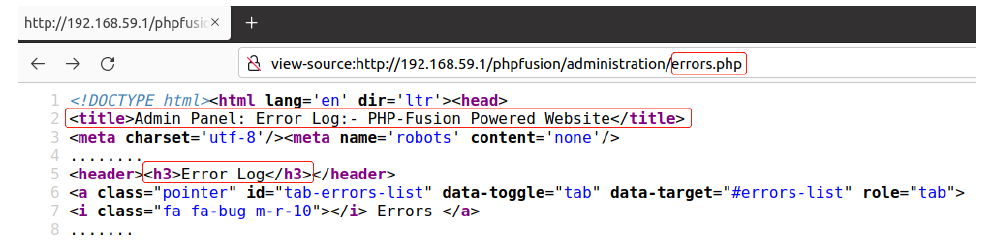
Figure 2. HTML code of viewing error log web interface page of